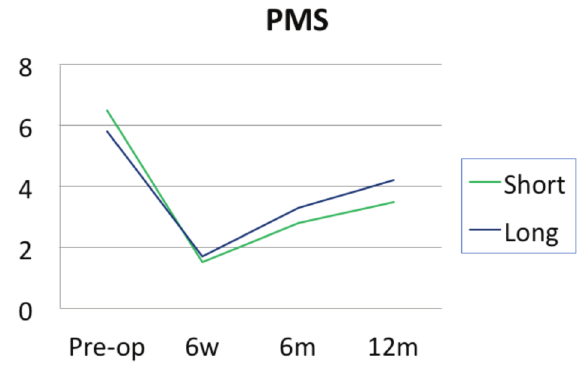
Pattern of the PMS Score in patients who had short nail Fig. 3: fixation and patients who had long nail